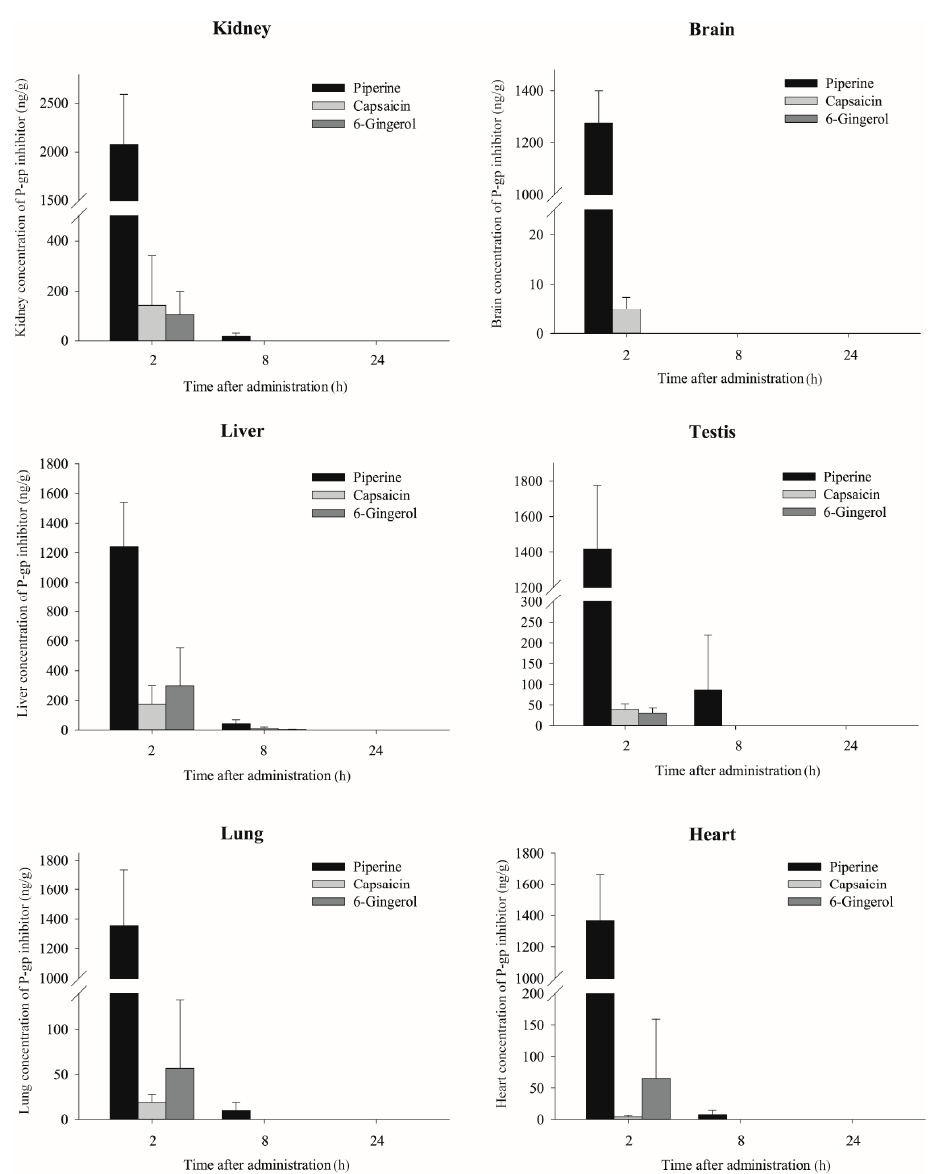
Figure 2. Tissue concentrations of piperine, capsaicin and [6]-gingerol after intraperitoneal administration in mice ( n = 6, mean ± SD).